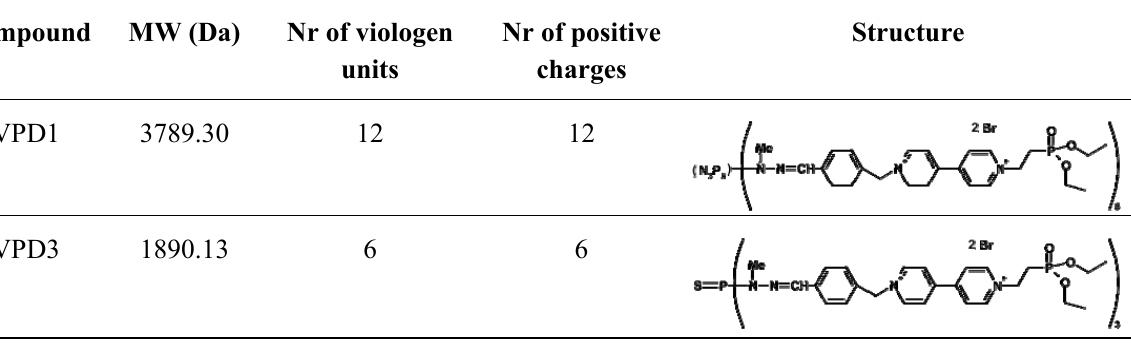
Figure 1. The structure and molar weight of tested viologen-phosphorus